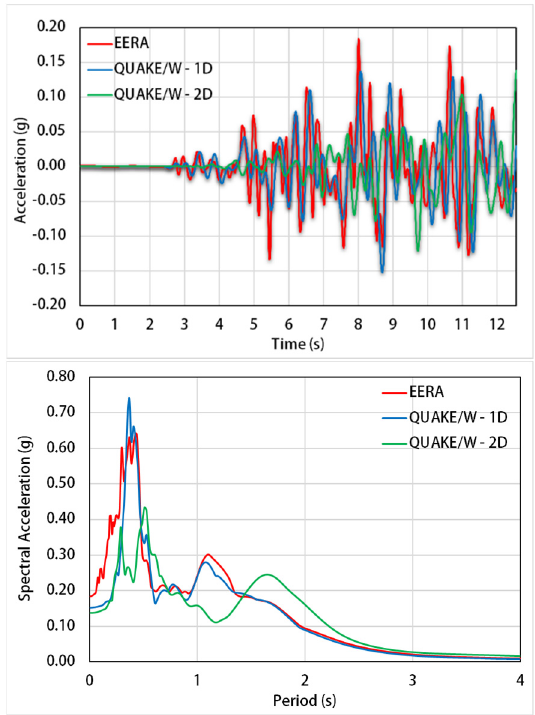
Figure 19. Comparison between 1-D and 2-D analyses performed by EERA and QUAKE/W for point 3 in terms of acceleration time history and spectral acceleration, for the Amoruso et al. [26] input. Table 7. PGA by 1-D and 2-D analyses for the Amoruso et al. [26] input at point 1, 2 and 3.